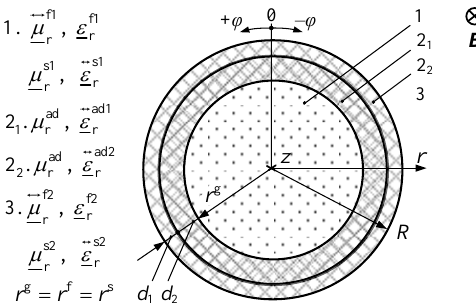
Fig. 1. The electrodynamical model of the open cylindrical multilayer gyroelectric-anisotropic-gyroelectric waveguide, where: g1 is the complex r ε μ is the complex permeability of permittivity tensor of gyroelectric core; g1 r gyroelectric core; a d1 is the permeability of the first anisotropic dielectric r  layer; a d1 r